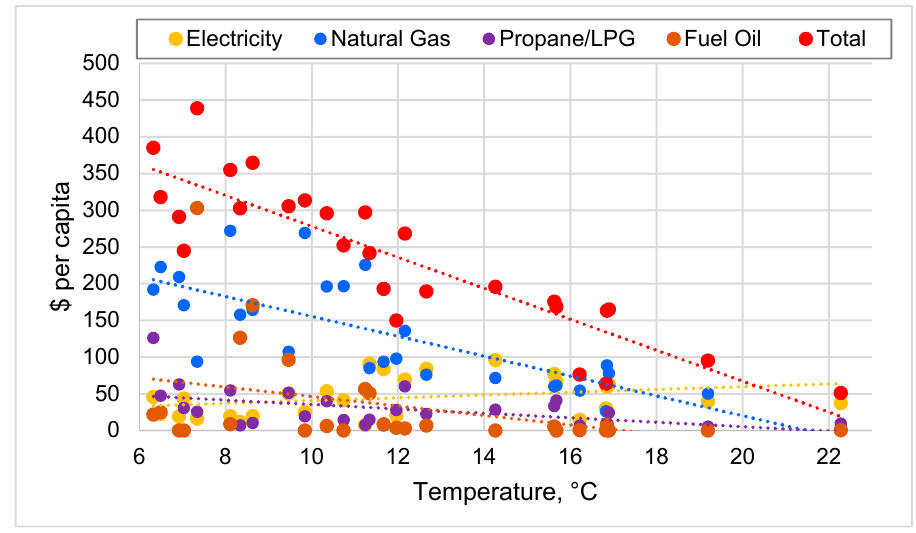
Figure A2. Residential per capita heating expenditure, at state fuel prices, against